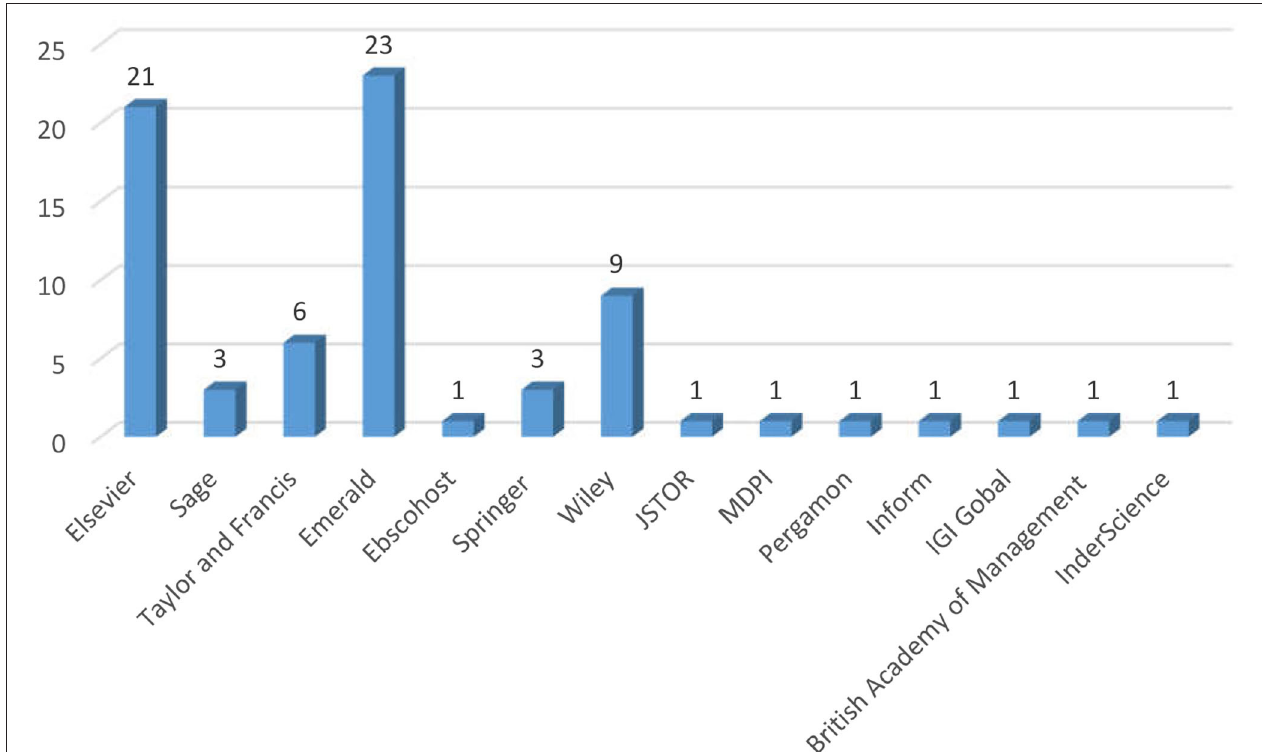
FIGURE 4 | Database-wise details of 73 articles